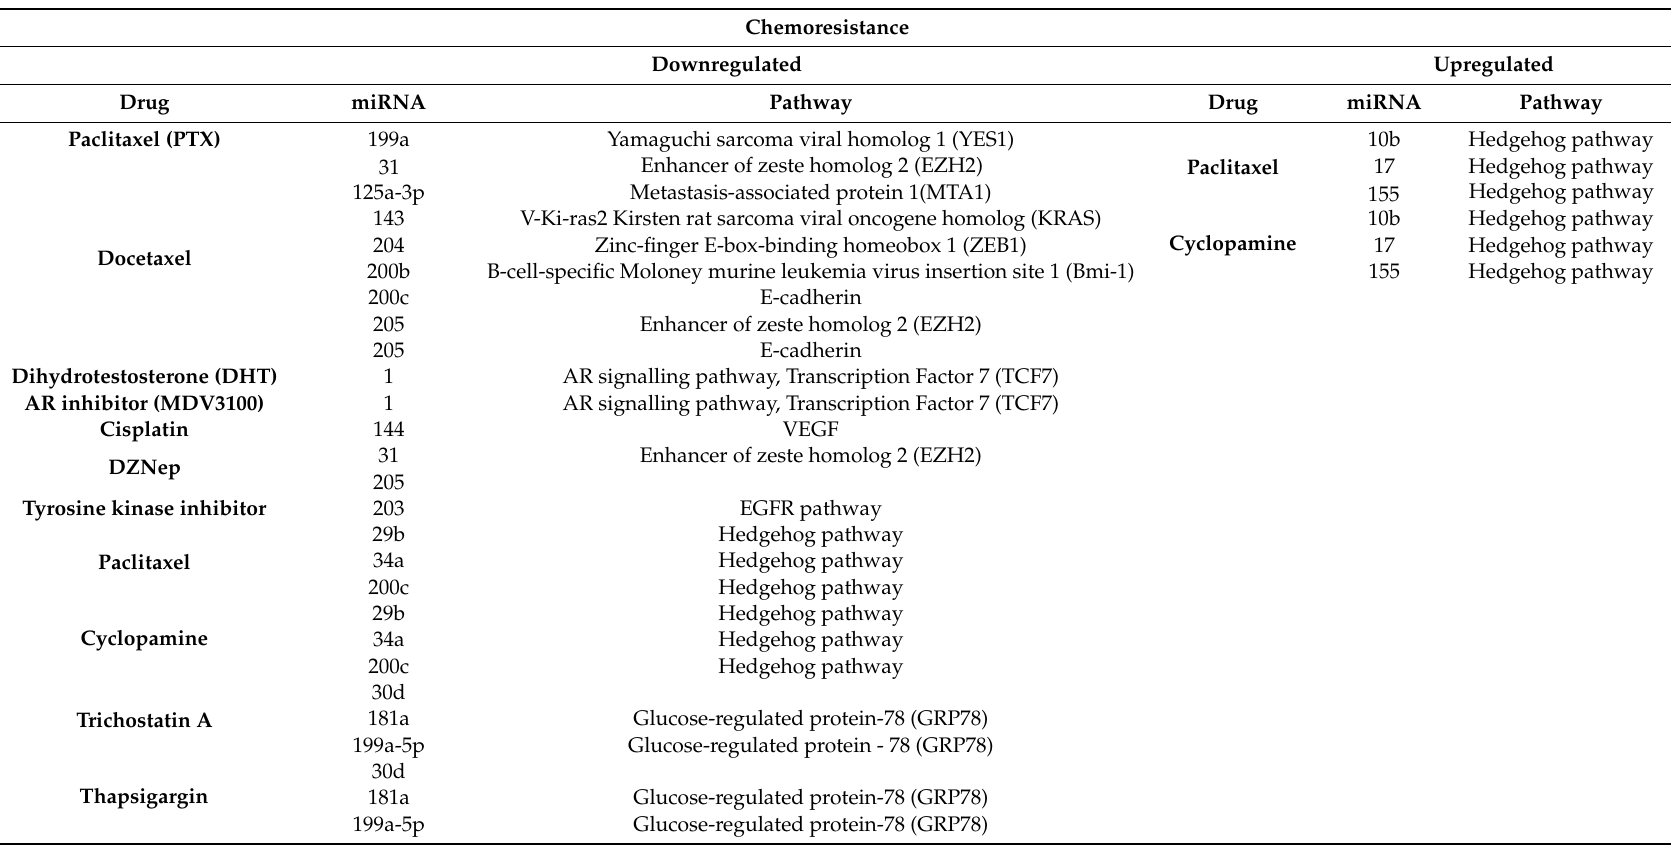
Table 2. Genetic pathways involved in